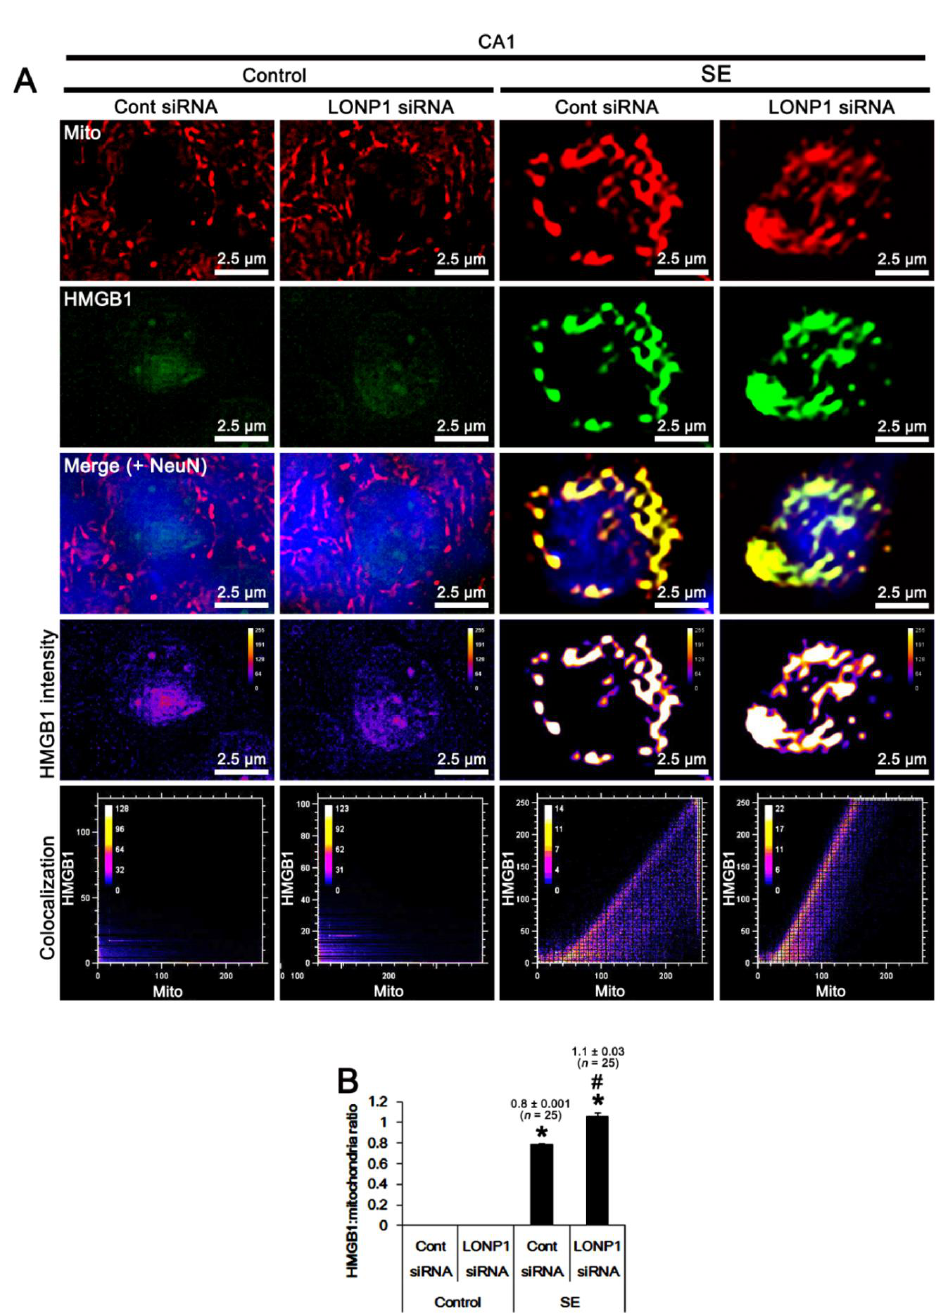
Figure 8. Effects of control siRNA and LONP1 siRNA on mitochondrial HMGB1 accumulation in CA1 neurons following SE. As compared to control siRNA (Cont siRNA), LONP1 siRNA increases mitochondrial HMGB1 translocation following SE. ( A ) Representative photos of level, intensity, and the degree of colocalization in mitochondria within CA1 neurons. ( B ) Quantification of the HMGB1/mitochondria ratio (the degree of colocalization) following SE (mean ± S.E.M.; * ,# p < 0.05 vs. control animals and control siRNA, respectively; one-way ANOVA).